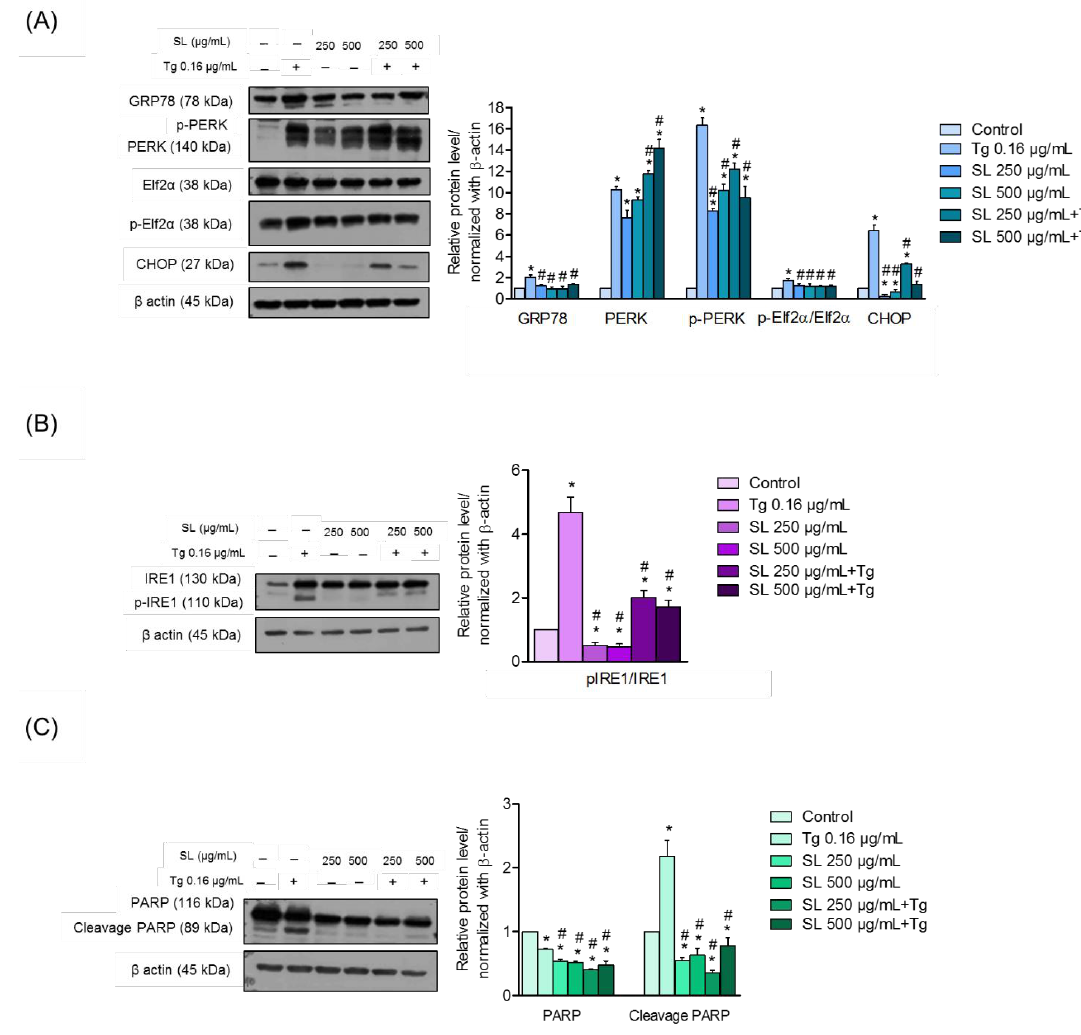
Figure 5. Characterization of unfolded protein in response to SL and the ER stress inducer. ( A ) Effect of SL pretreatment on the level of the GRP78 protein and PERK – CHOP pathway determined by Western blot analysis and the relative protein level was calculated by densitometry. β -actin was used to confirm the equal loading of samples. ( B ) The effect of the SL pretreatment effect on the downregulation of the IRE1α pathway determined by Western blot analysis and the relative protein level was calculated by densitometry. β -actin was used to confirm the equal loading of samples. ( C ) Apoptosis-related protein PARP and its cleavage form were determined. Blots were re-probed with β -actin to confirm the equal loading of samples; data are presented as mean ± SD ( n = 3). * p < 0.05 versus the control group and # p < 0.05 versus the Tg-treated group.